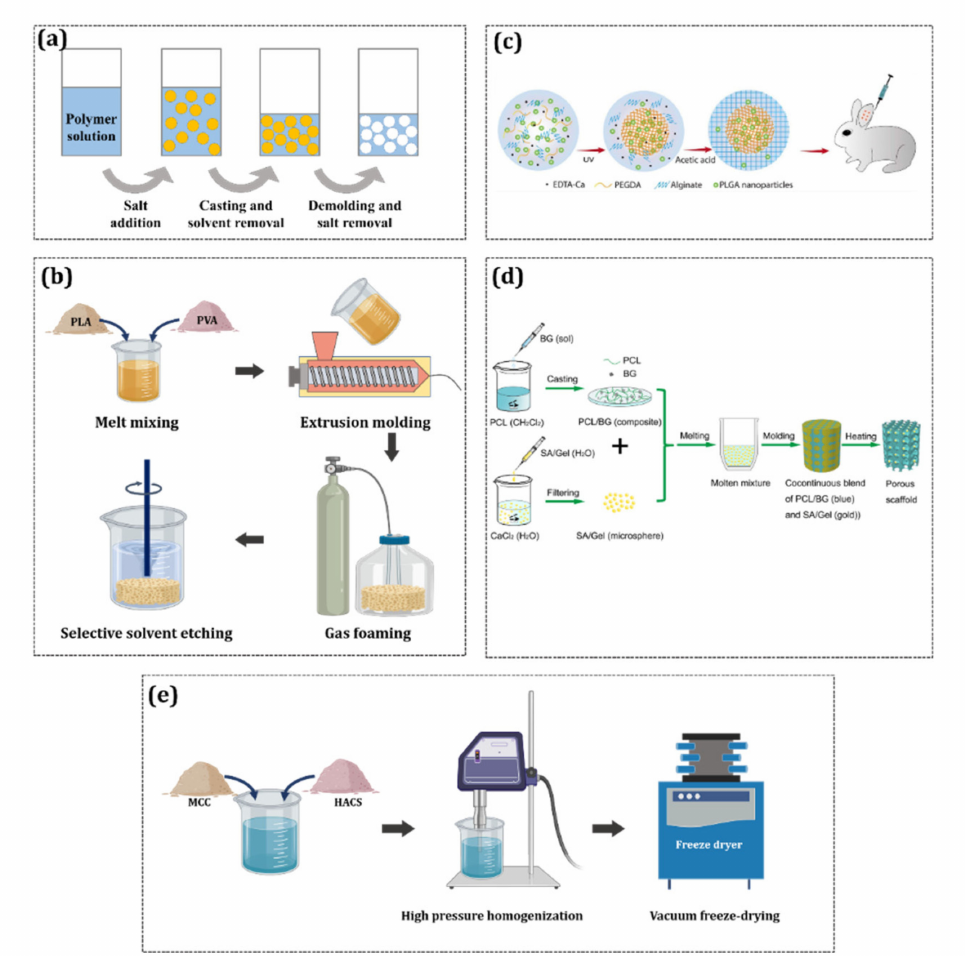
Figure 6. Hydrogel fabrication techniques: ( a ) Solvent-casting / particulate-leaching [138]; ( b ) gas foaming [139]; ( c ) phase separation [140]; ( d ) melt molding [141]; and ( e ) freeze drying [142] (images adopted with